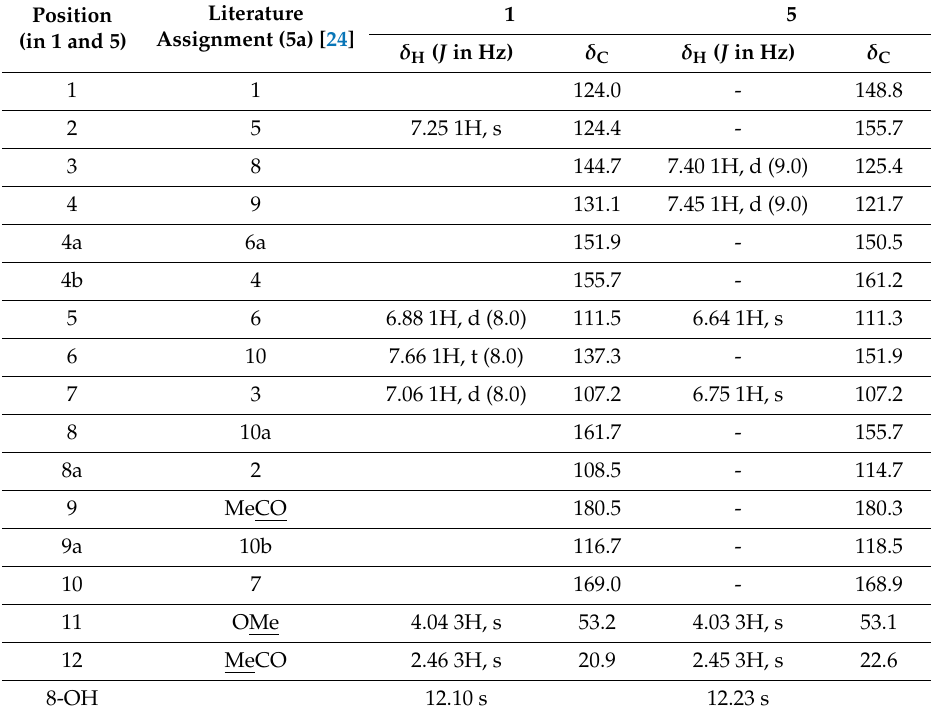
Table 1. 1 H and 13 C NMR data for xanthones 1 and 5 (at 400 and 100 MHz respectively, in CDCl 3 , δ in ppm). Position